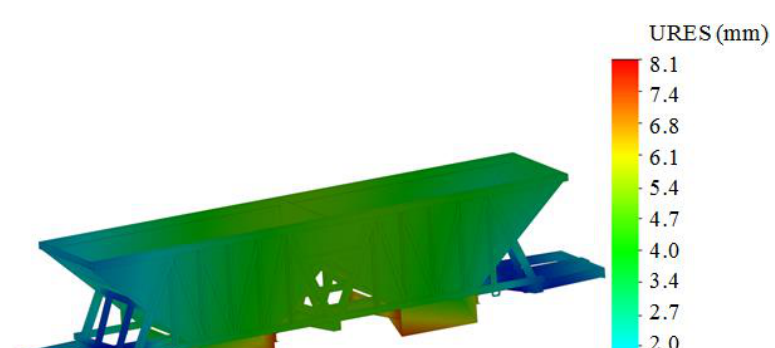
Figure 7. The stressed state of the hopper.